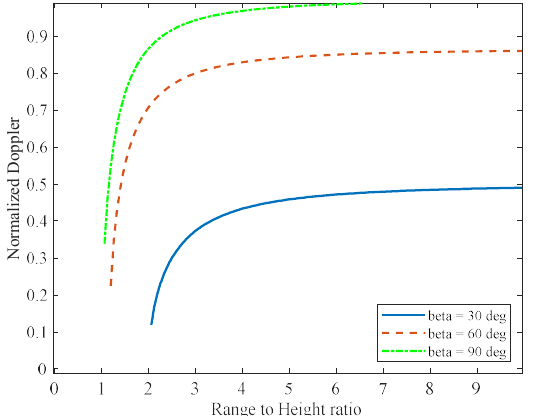
Figure 5. Clutter Doppler frequency at different ranges.